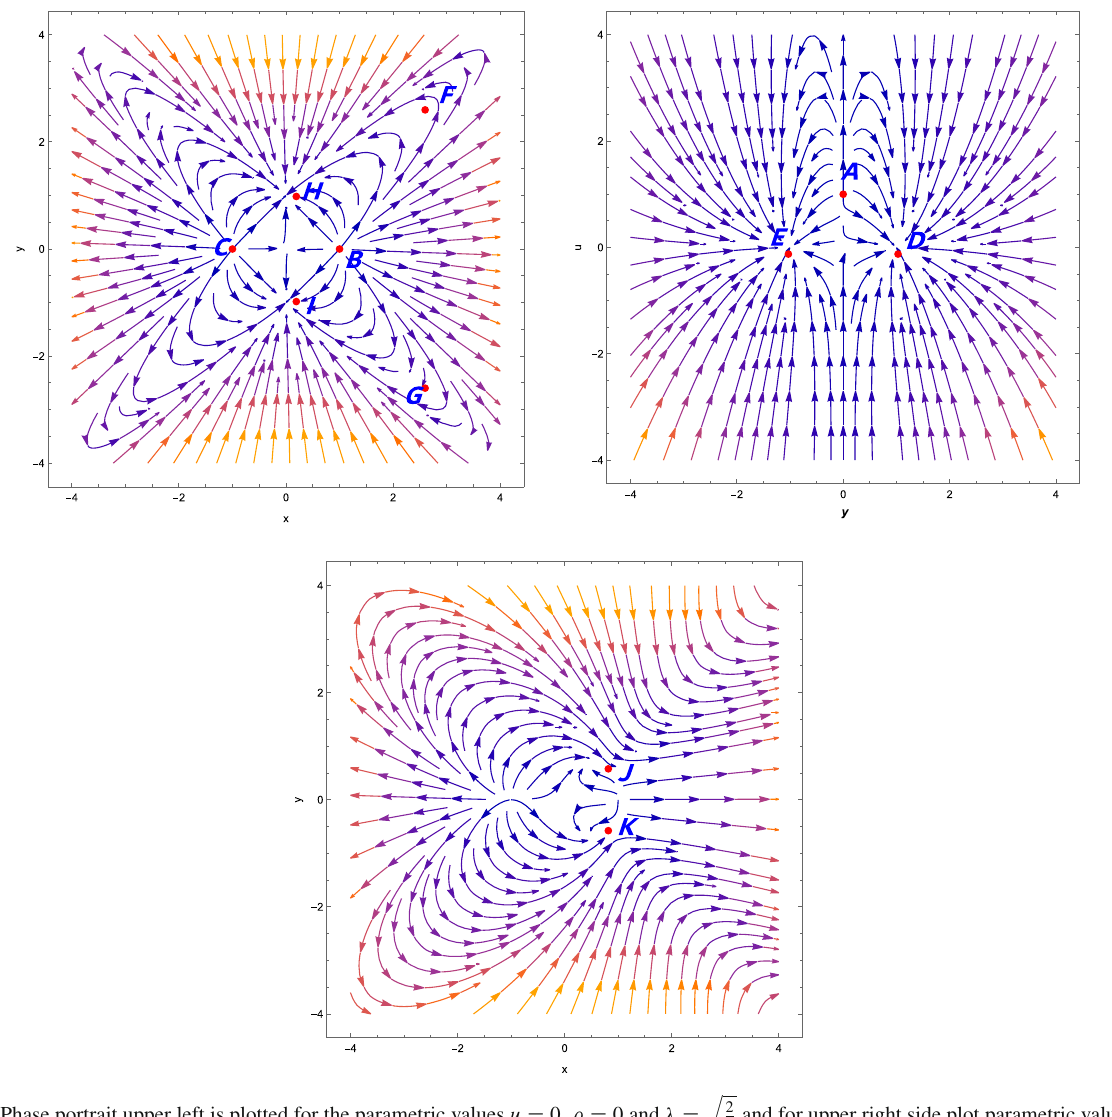
Fig. 8 Phase portrait upper left is plotted for the parametric values u = 0, ρ = 0 and λ = x = 0, ρ = 0, σ = 1 . The lower phase portrait is for the parametric values u = 0, ρ = 0, λ = 4